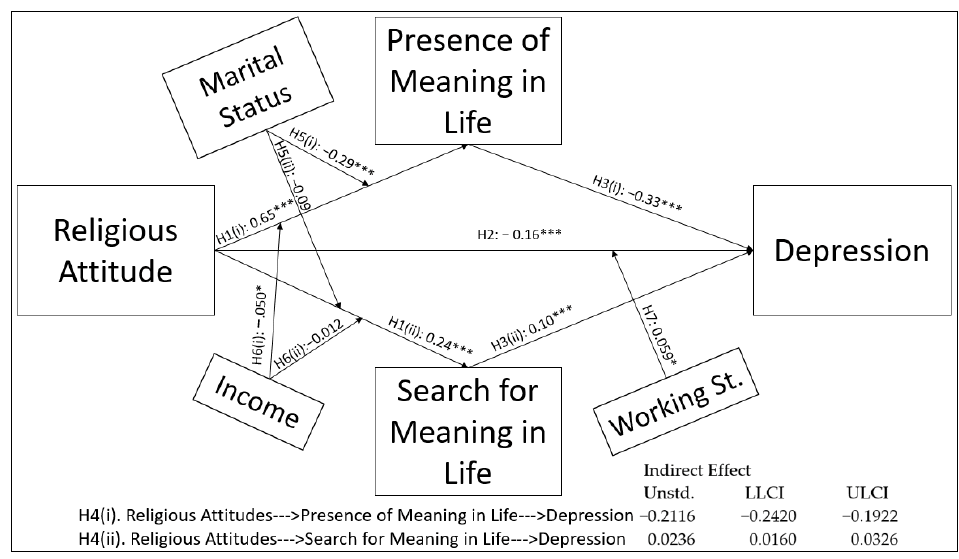
Figure 4. Hypothesis values of proposed model (*** p < 0.001, * p < Table 6. Test results of hypotheses.